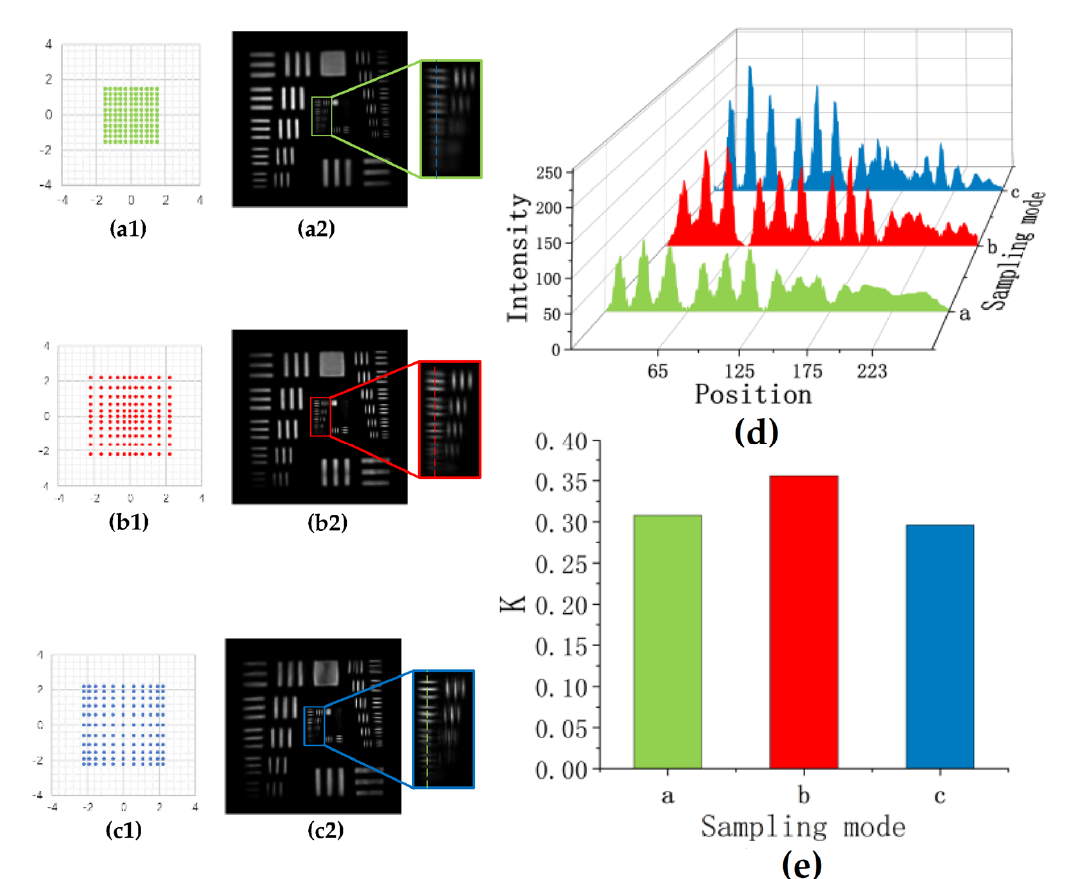
Figure 8. Experimental sampling mode, imaging results, and analysis. ( a1 ) Uniform sampling with 70% overlap of adjacent apertures. ( b1 , c1 ) Non-uniform sampling. ( b1 ) The overlap rate is low in the central area, and the overlap rate gradually increases toward the surrounding area. ( c1 ) The overlap rate in the center area is high, and the overlap rate gradually decreases toward the surrounding area. ( a2 − c2 ) The corresponding reconstructed image results and enlarged images. ( d ) The pixel intensity distribution map of the horizontal stripe at group number 2 intercepted at the drawn line. ( e ) The structural similarity values K corresponding to different reconstructed images.